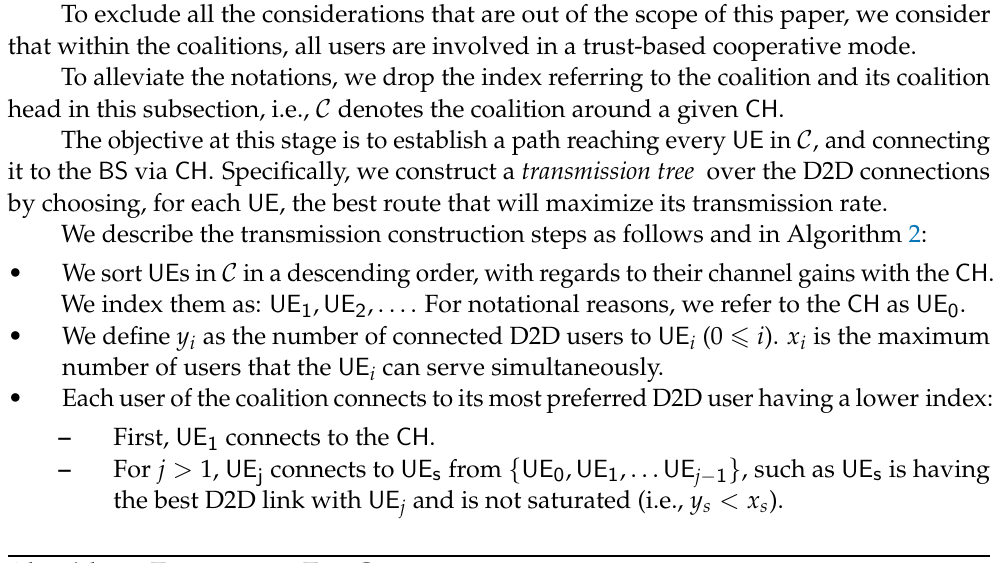
Algorithm 2 Transmission Tree